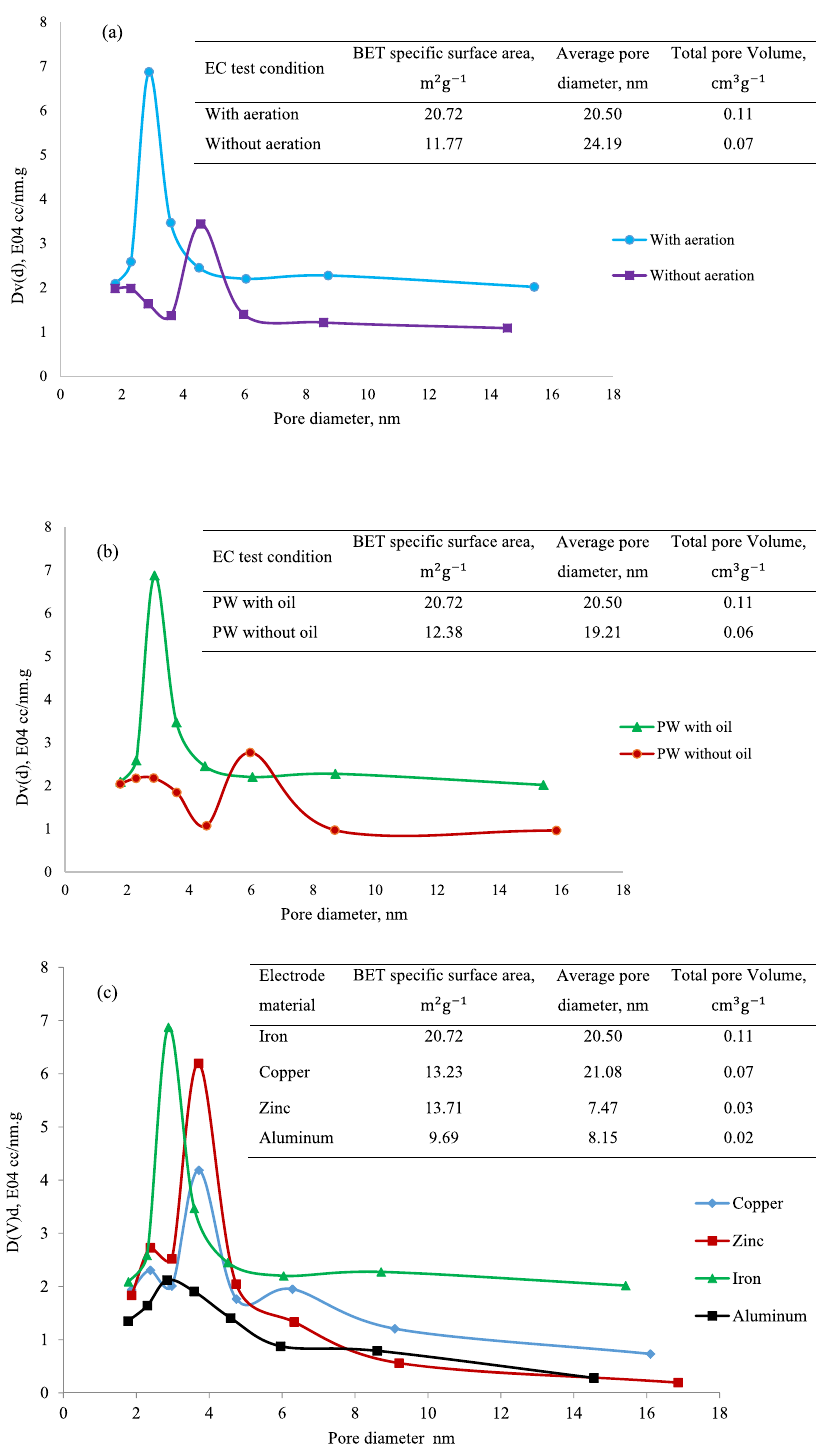
Fig. 4 The pore size distribution curves for various metal hydroxides particles at different conditions. a With/without aeration; b with/ without oil; c four electrode materials. (Experimental conditions: pH 7, current density 25 mA cm − 2 , salinity 43.5 g L − 1